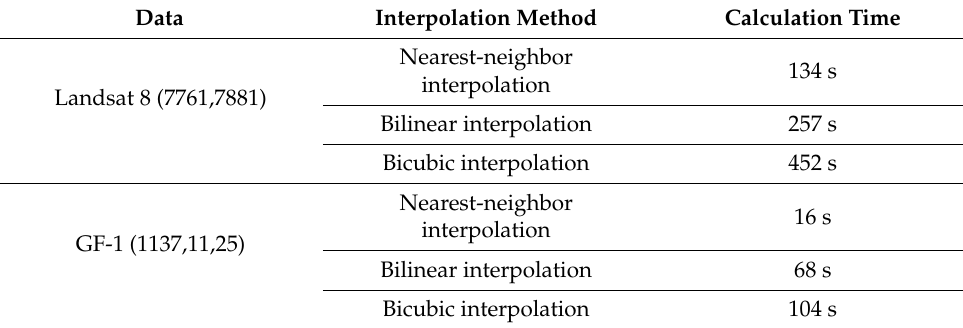
Table 5. Calculation efficiency of different interpolation methods.